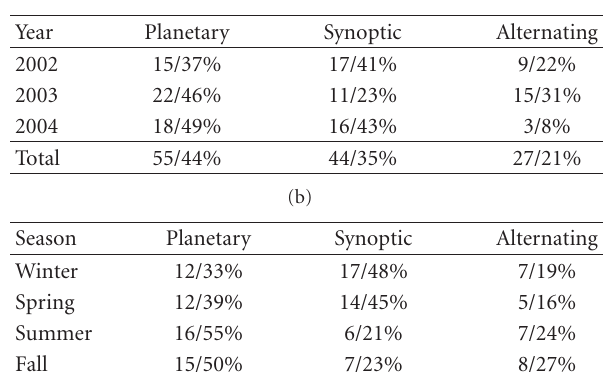
Table 3: Planetary-, synoptic-, and alternating-scale dominance results for the three-year period (2002–2004) analysis and for each season performed in this study, over the entire NH. The number and percentage for each year or season and the total is